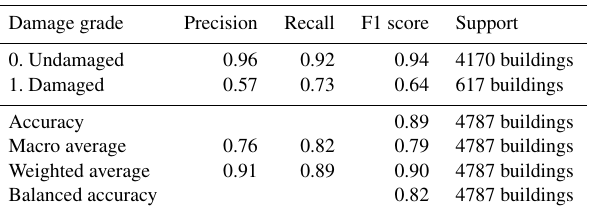
Table 3. Test-set performance metrics for binary classification for the 2015 Gorkha